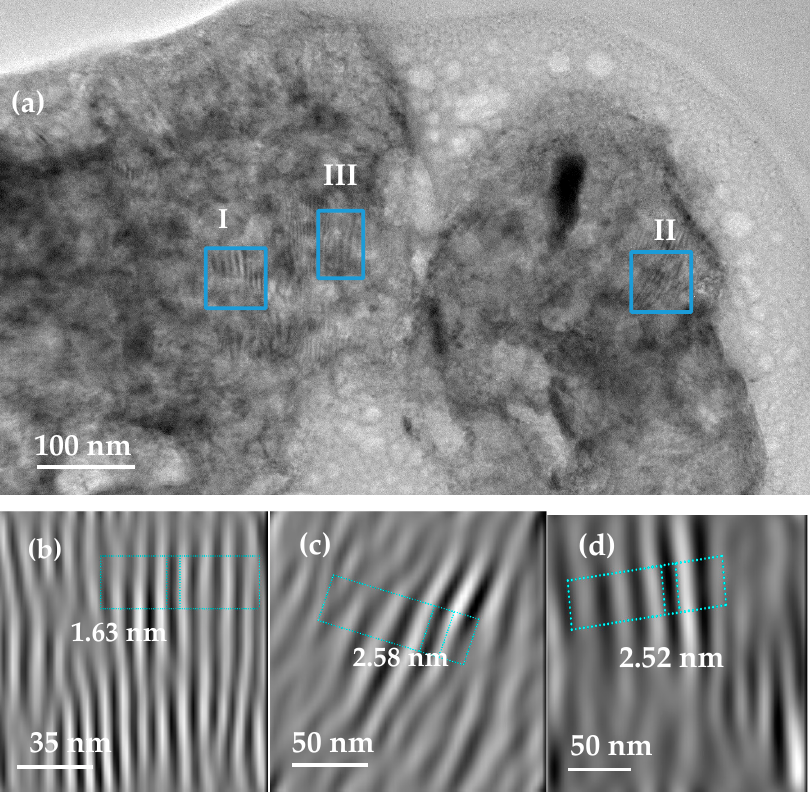
Figure 9. Field emission high resolution transmission electron microscopy (FE-HRTEM) of ( a ) MgH 2 /10 wt.% Zr (x) Ni (y) nanocomposite; ( b ) the lattice image of zone I; ( c ) the lattice image of zone II; ( d ) the lattice image of zone III.